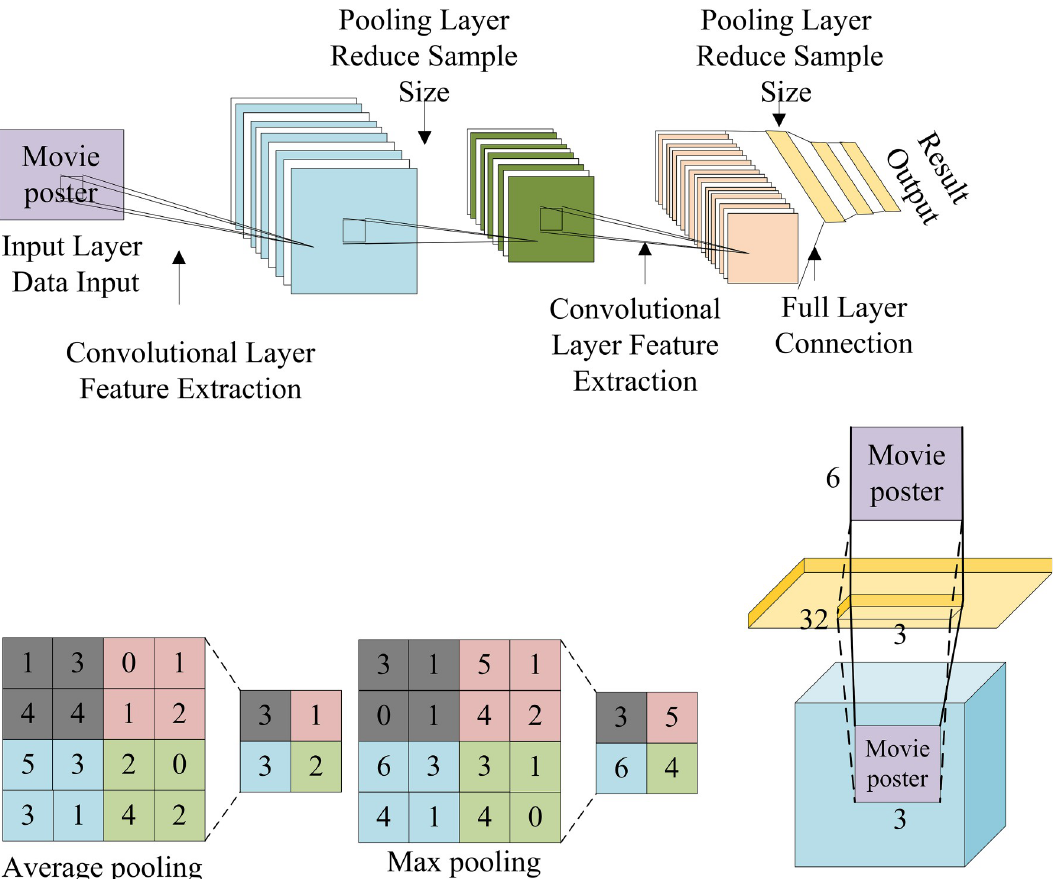
Fig 2. Working principle of DCNN (a: DCNN, b: The pooling operation, c: The convolution operation).